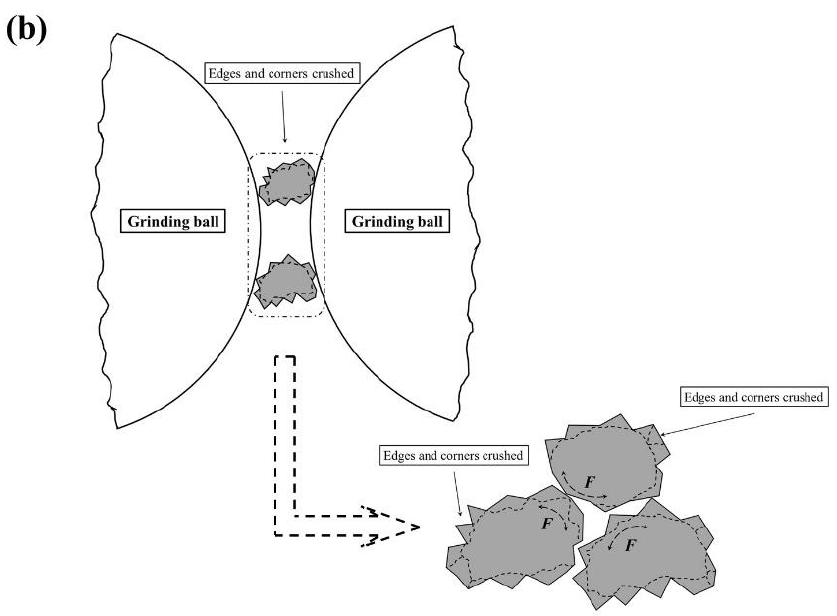
Figure 4. Schematic diagram of tailing particle damage during ( a ) Stage 1: Raw–0.5 h ( b ) Stage 2: 0.5–1 h.